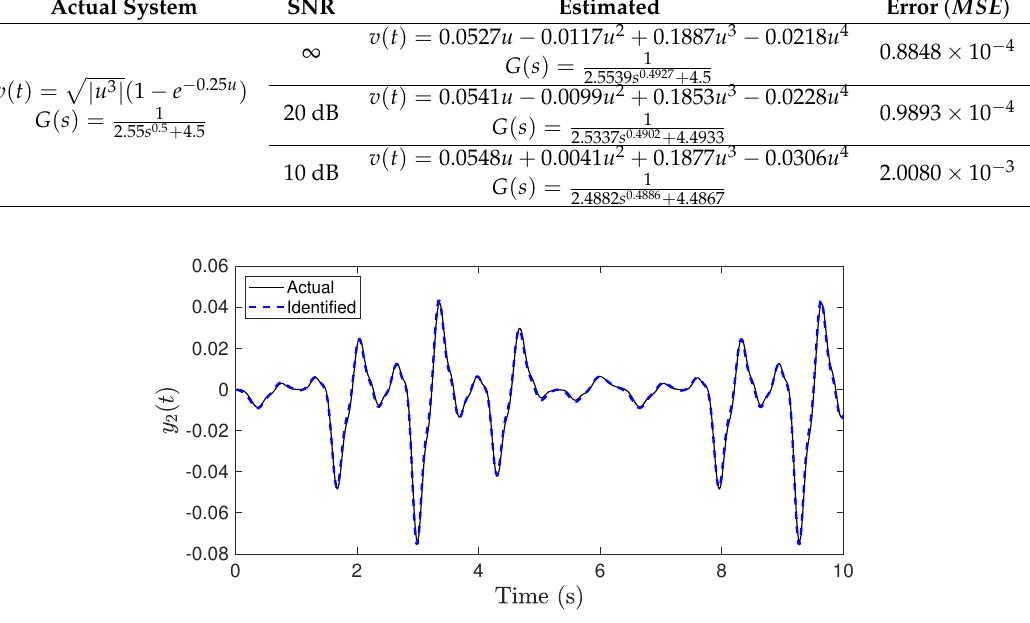
Figure 3. Overall time response comparison for Example 1.